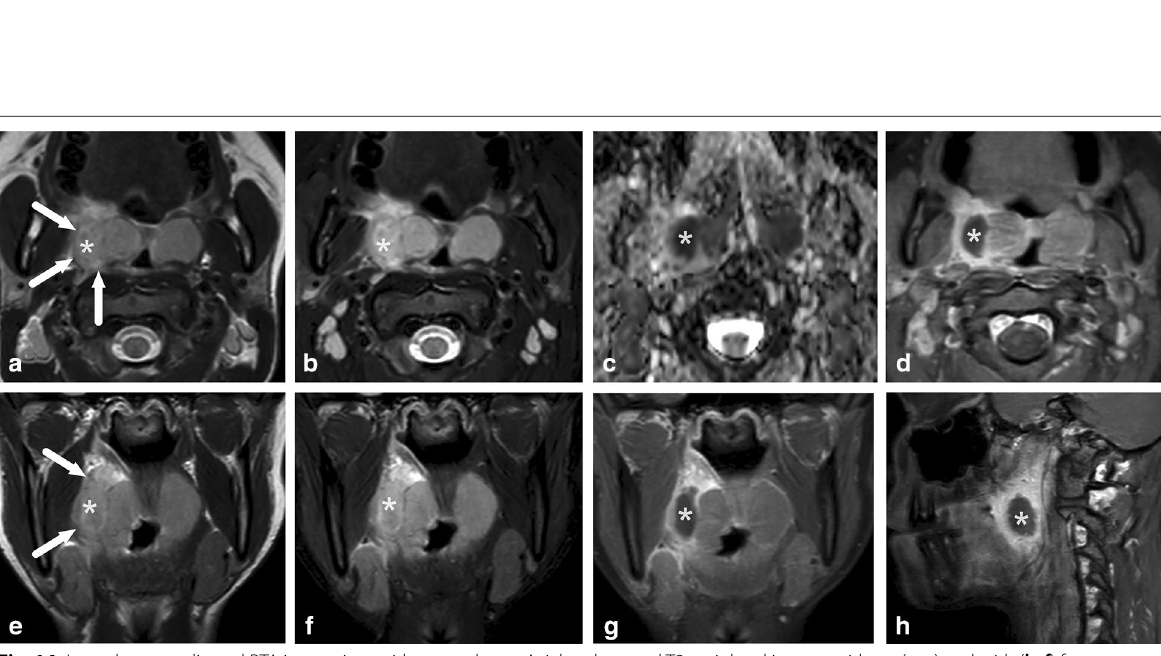
Fig. 14 Lateral uncomplicated PTA in a patient with a sore throat. Axial and coronal T2-weighted images without ( a , e ) and with ( b , f ) fat suppression demonstrate an abnormal collection (asterisk) with intermediate T2-signal between the tonsil and a swollen pharyngeal constrictor muscle (arrows). Axial ( d ), coronal ( g ), and sagittal ( h ) fat-suppressed post-contrast T1-weighted images show a centrally non-enhancing fluid collection, and low ADC ( c ) suggests purulence. PTA was found upon